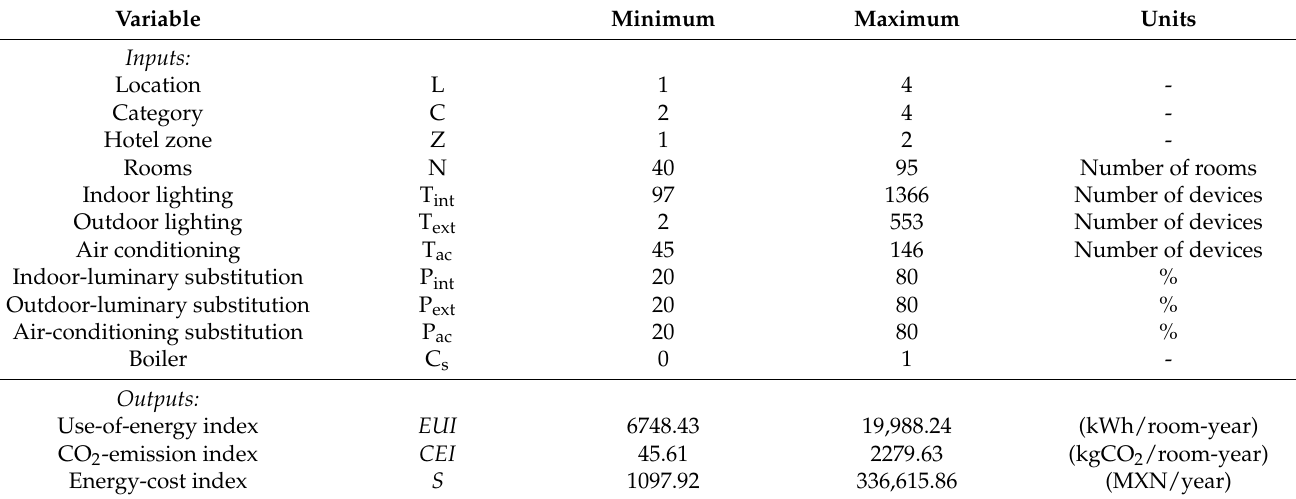
Table 5. Nomenclature and values of input and output